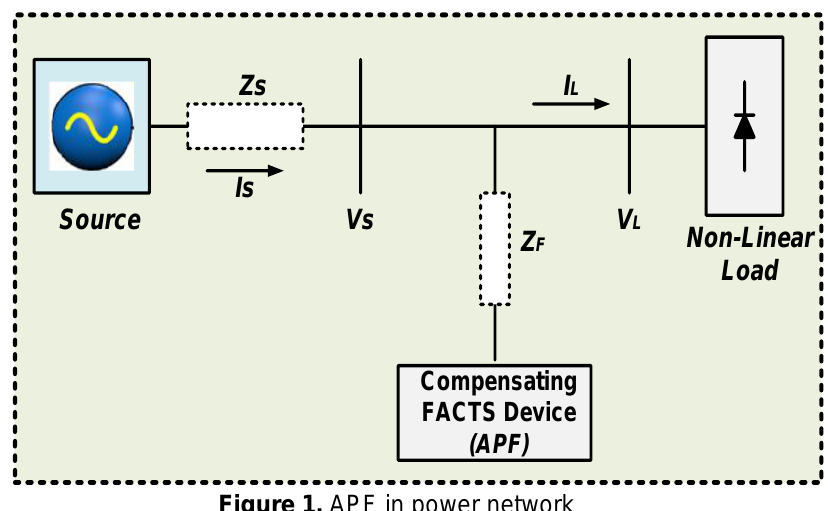
Figure 1. APF in power